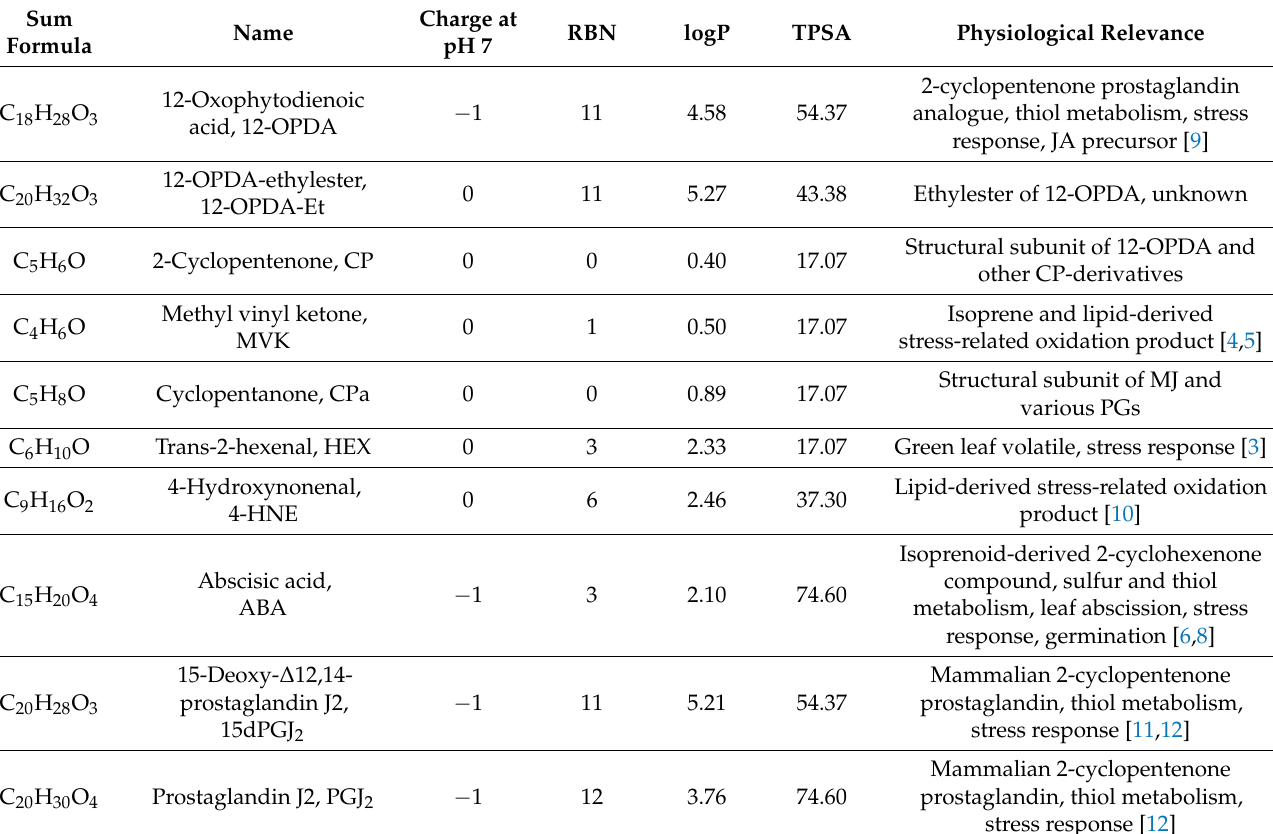
Table 1. Properties of 12-OPDA and related compounds. The list gives chemical properties, common names and predicted physicochemical and pharmacological properties of conjugated carbonyl compounds (CCCs) and related compounds. TPSA, topological polar surface area; logP, partition coefficient; RBN, number of rotatable bonds. The table also provides some information on bioactivities of the compounds as given in the